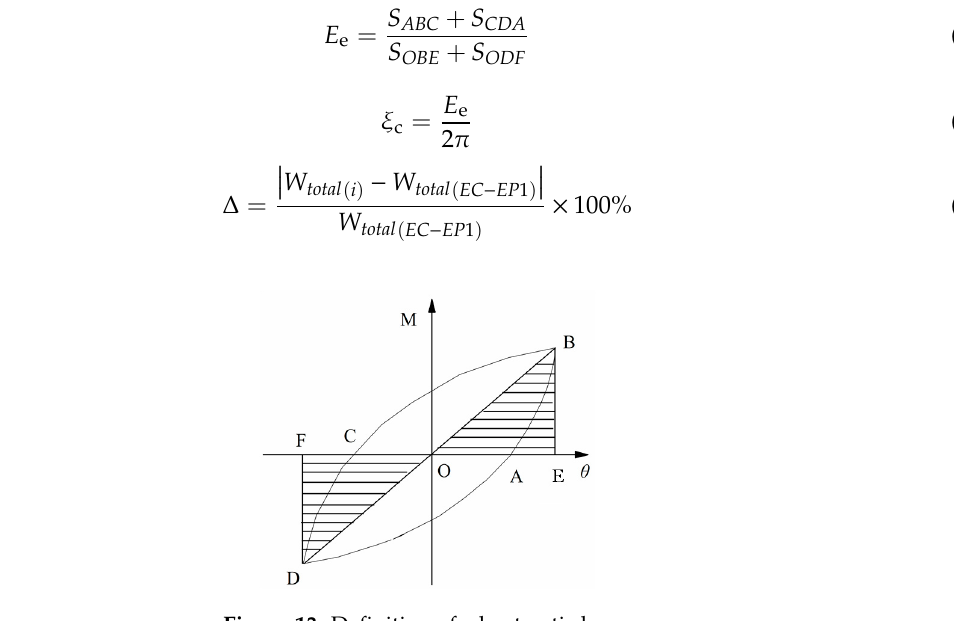
Figure 13. Definition of a hysteretic loop.